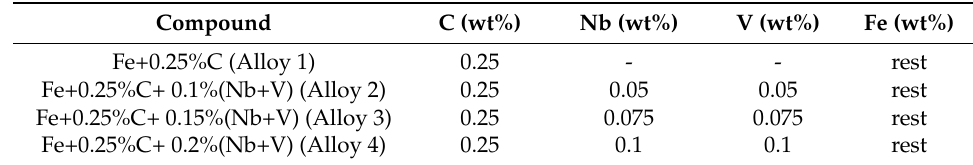
Table 1. Nominal chemical compositions of powder metal